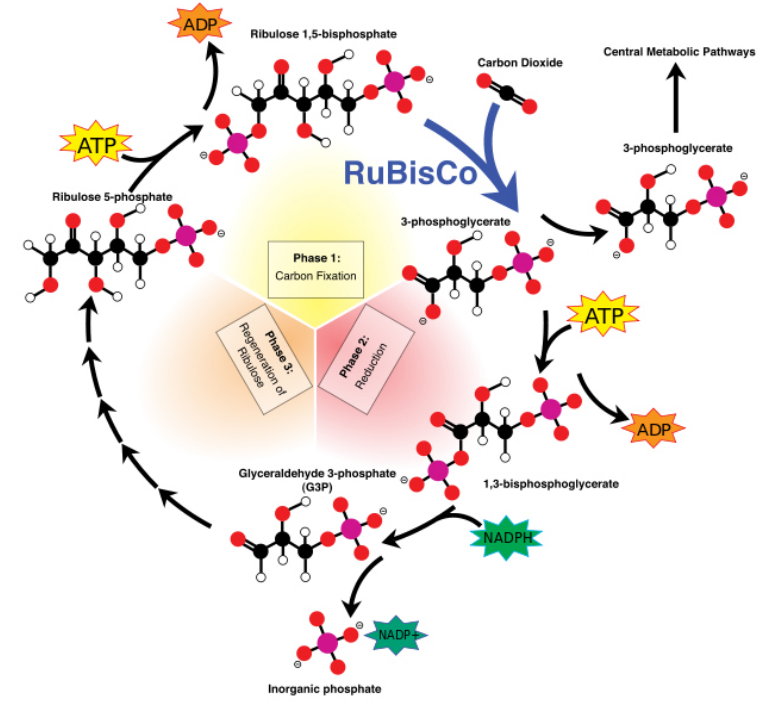
Figure 9. The Calvin cycle. Phase 1: Carbon fixation by ribulose-1,5-bisphosphate carboxylase/oxygenase (RuBisCO); Phase 2: Reduction; Phase 3: Regeneration of